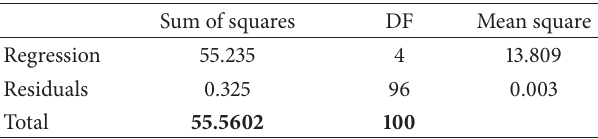
Table 3: Analysis for Marquardt’s method. Sum of squares DF Mean